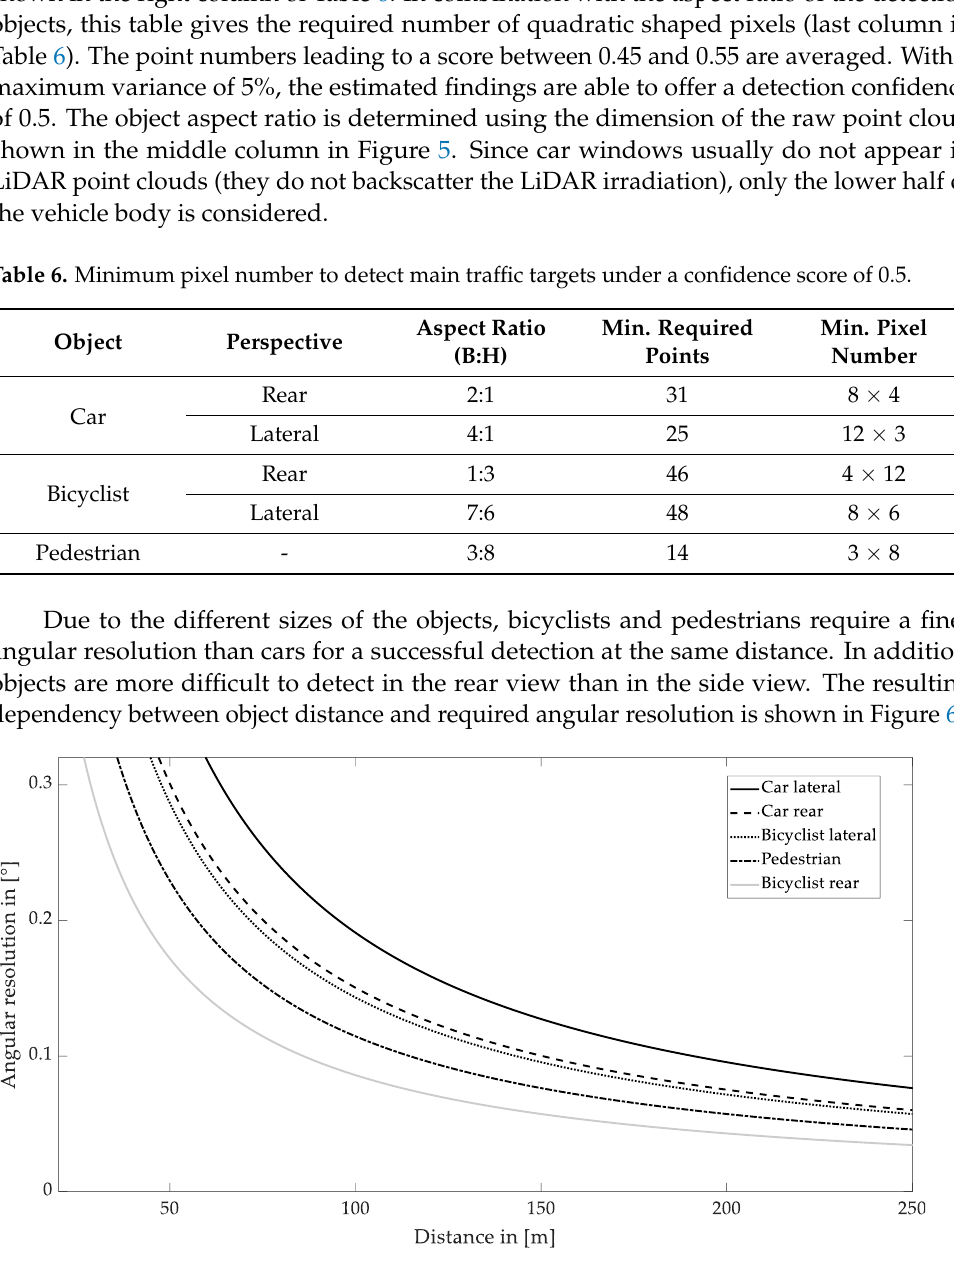
Figure 6. Required angular resolution for quadratic shaped pixels and different objects as a function of distance with a confidence score of 0.5.